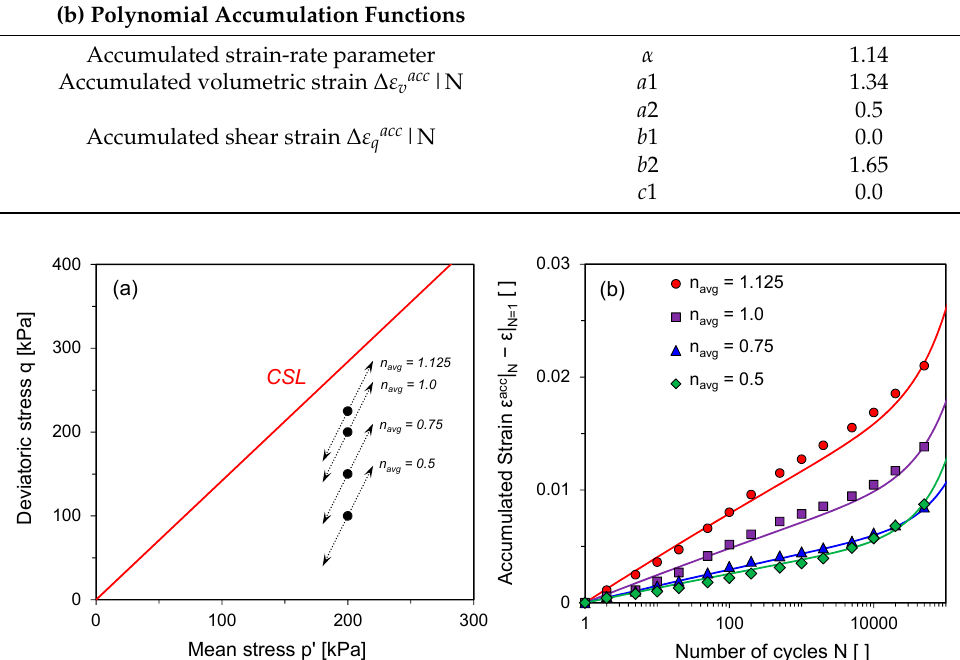
show that the far-field surface settlement profiles are zero at cycles N = 1, 100, and 10,000. It is confirmed that the generated mesh and domain size has no effect on the physical response during the simulation. the simulation.